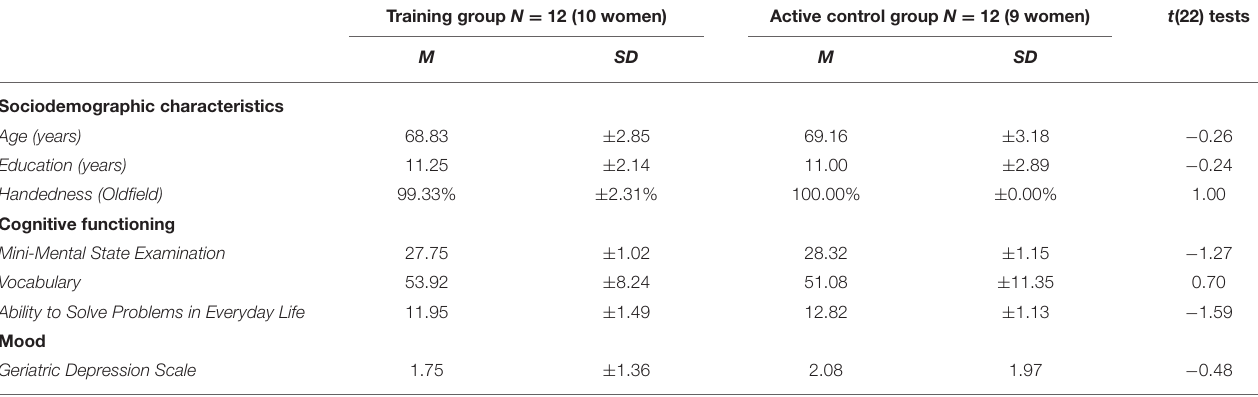
TABLE 1 | Means ( M ) and standard deviations ( ± SD ) of the demographic characteristics, cognitive functioning, and mood measures at pre-training for the training group vs. active control group (ACG)